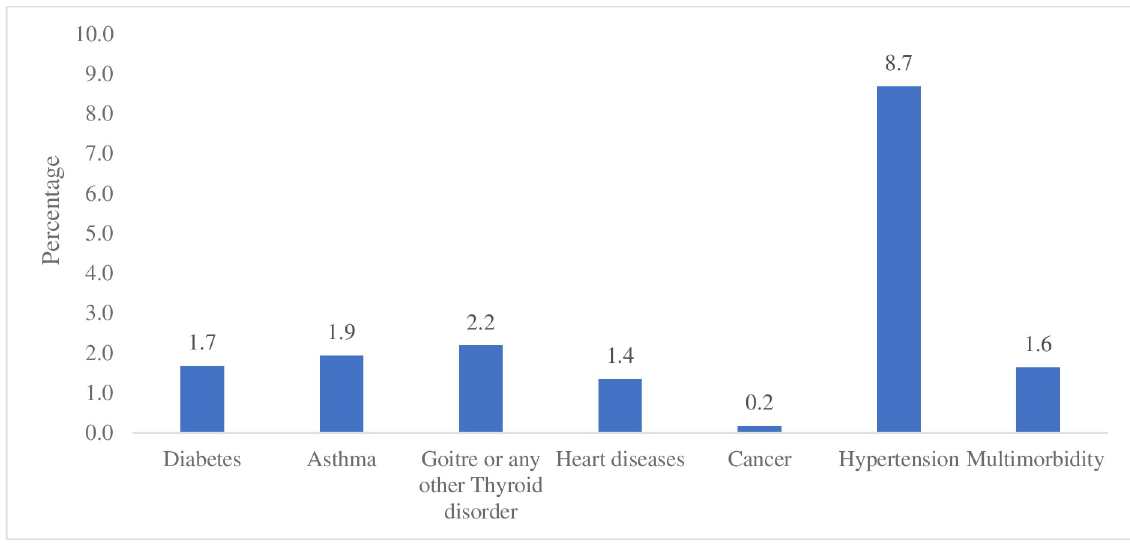
Fig 2. Percentage of multimorbidity among women aged 15–49 years in India, 2015–16.